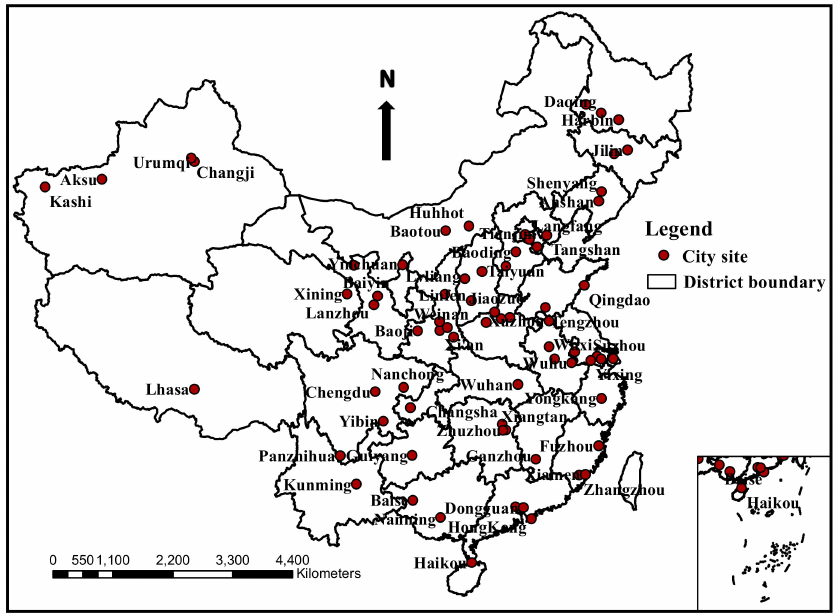
Figure 1. The distribution of city sites reviewed in this study around